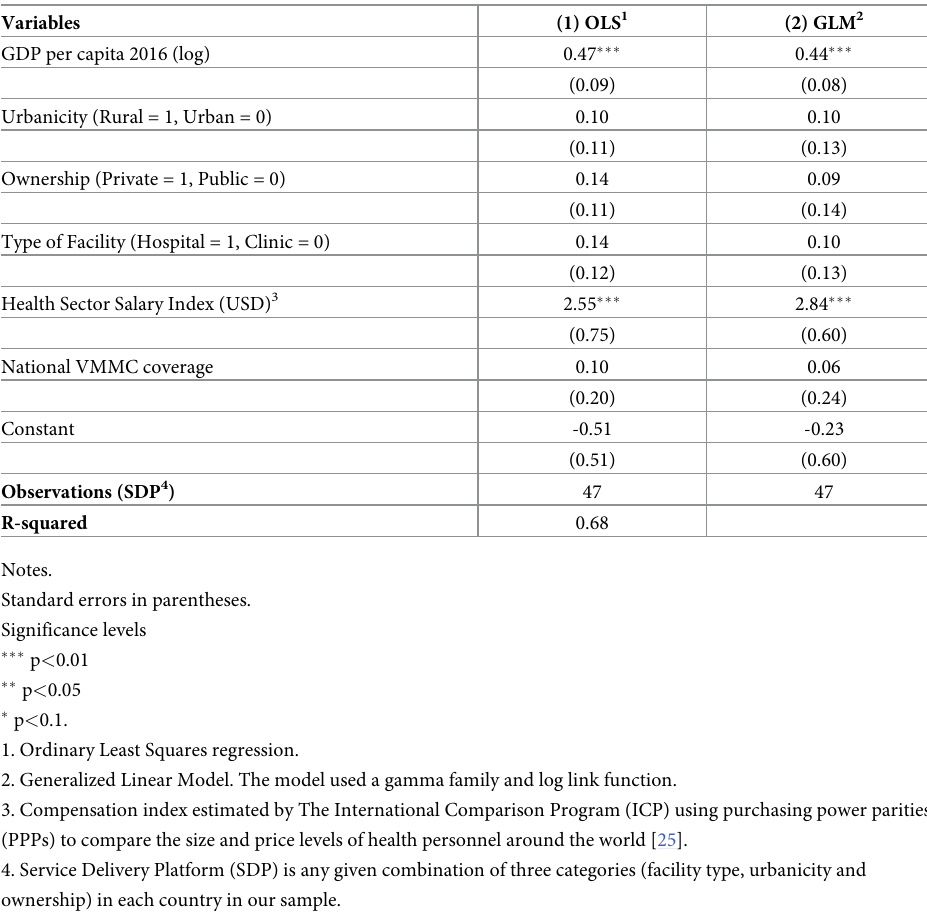
Table 3. Extrapolation regression models–dependent variable is SDP-Level VMMC unit